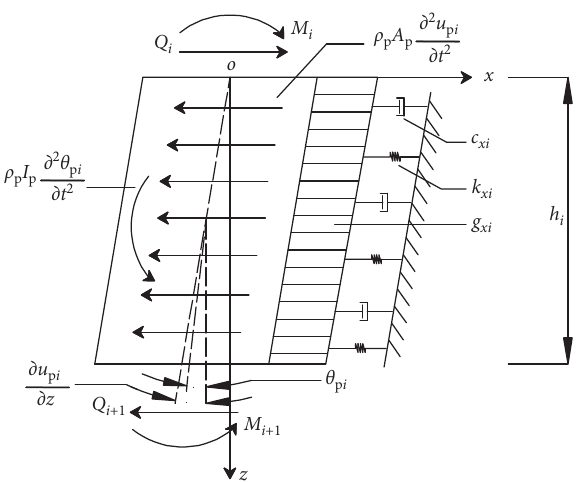
Figure 2: Schematic illustration of the i th pile unit.